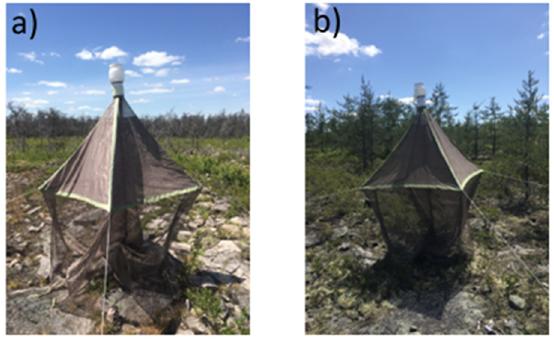
Figure 2. Malaise traps at the burned site ( a ) and reference site ( b ) in the summer of 2020. We sampled pre-fire stand density, ground cover, and collected soil samples in June 2019 at each of the sites from a 20 m 2 plot centered on the Malaise trap. Subsamples of 5 mL were taken from collected soil and placed in a drying oven at 60 ◦ C for 48 h to determine moisture content. Samples were then ashed in a 500 ◦ C muffle furnace to determine organic content. We used a spherical densiometer to calculate canopy closure at each site and assessed fire severity on a five-point scale ranging from 1 being unburned to 5 being no live material remaining on completely burned trees/crowns.